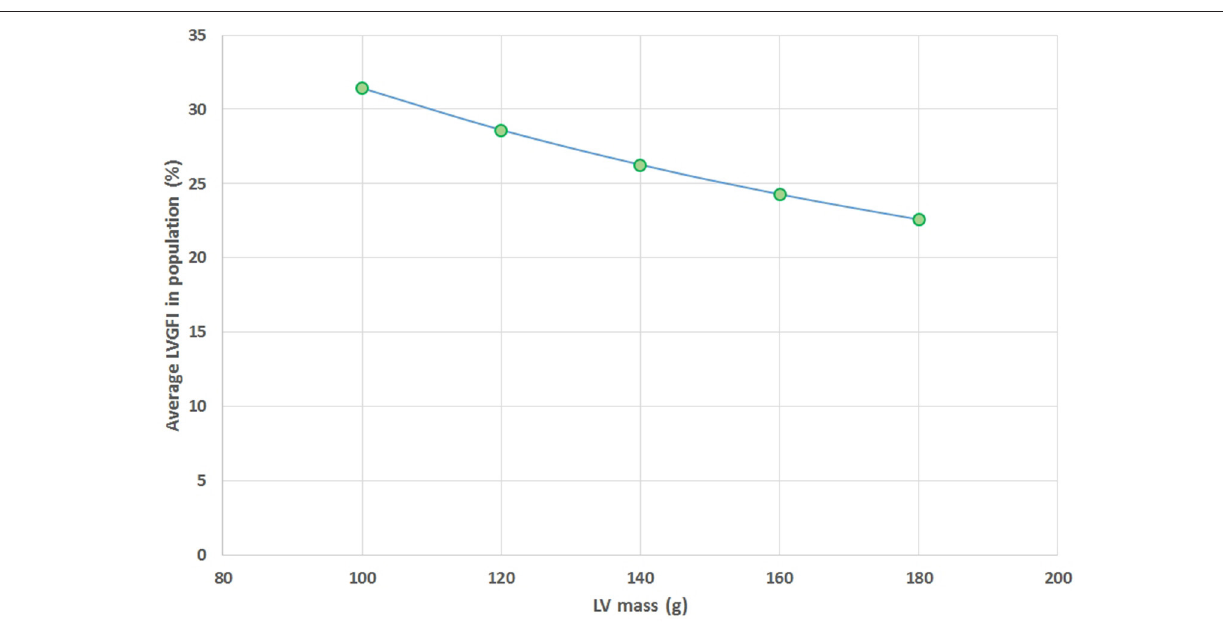
FIGURE 8 | Average values found for LVGFI on the basis of actual patient data for SV, ESV and EDV, but with fixed values for LV mass assumed for all patients ( N 96), and set at 100, 120, 140, 160, and 180 grams. This theoretical curve shows a monotonous decline as LV mass increases.